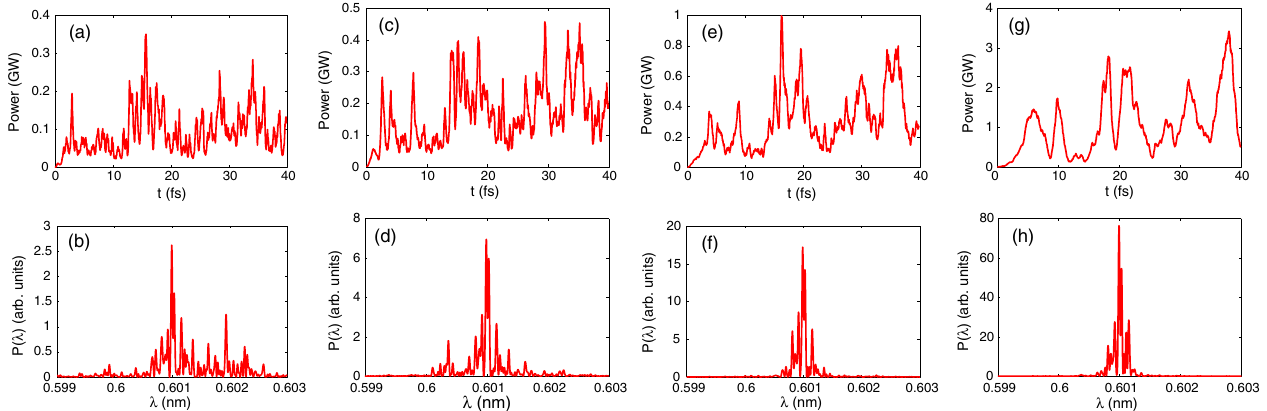
FIG. 5. SASE radiation power and spectrum at the exit of the 1st undulator in U2 [(a) and (b)]; at the exit of the 2nd undulator in U2 [(c) and (d)]; at the exit of the 3rd undulator in U2 [(e) and (f)]; at the exit of the 5th undulator in U2 [(g) and (h)]. The spectrum brightness P ð (cid:2) Þ is normalized to the radiation peak spectral brightness at the exit of U1 [Fig.